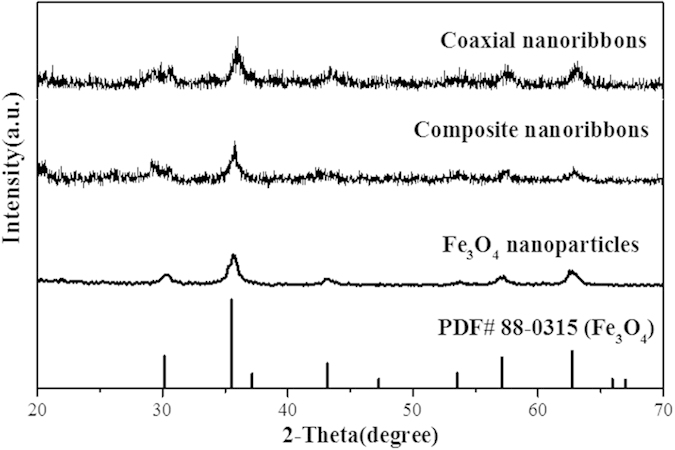
XRD patterns of Fe3O4 nanoparticles, [Fe3O4/PMMA]@{[Dy(BA)3phen+Eu(BA)3phen]/PANI/PMMA} coaxial nanoribbons (Sa3@Sb2) and composite nanoribbons with PDF standard card of Fe3O4.